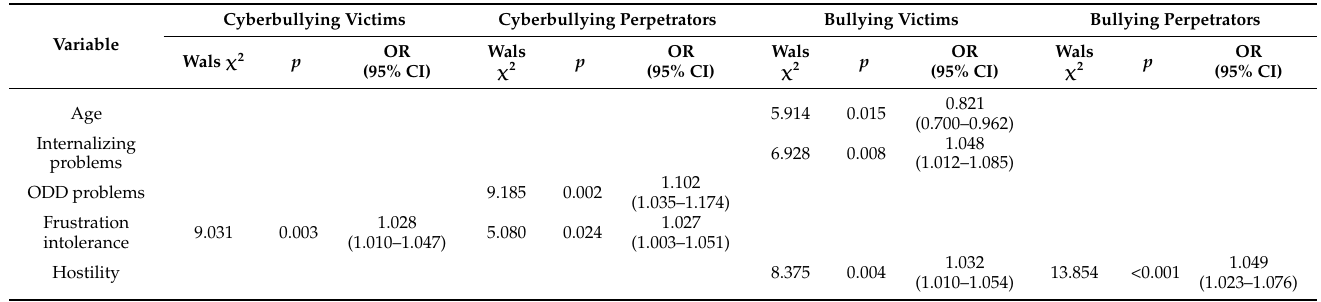
Table 4. Factors related to being cyberbullying and traditional bullying perpetrators and victims: Logistic regression analysis with conditional forward selection; CI: confidence interval; ODD: oppositional defiant disorder; OR: odds ratio.